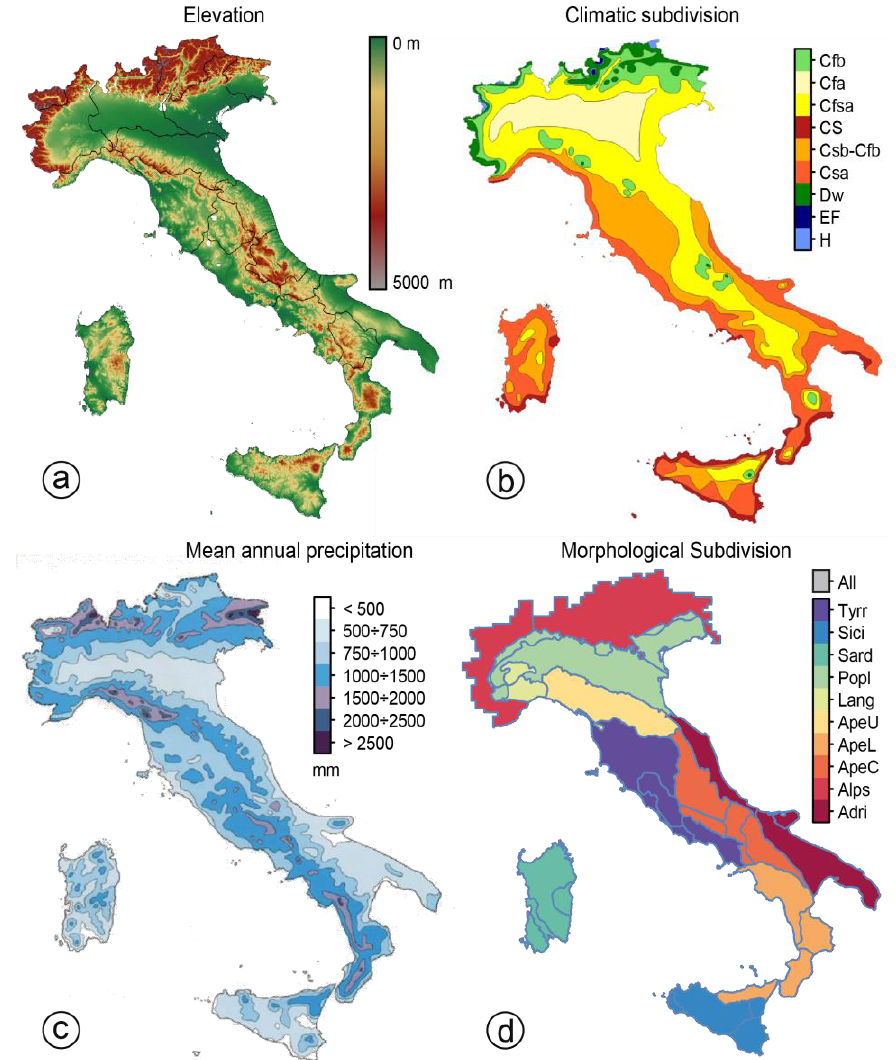
Figure 1. ( a ) Digital Elevation Model (DEM) at 230 m × 230 m pixel resolution; ( b ) Climatic